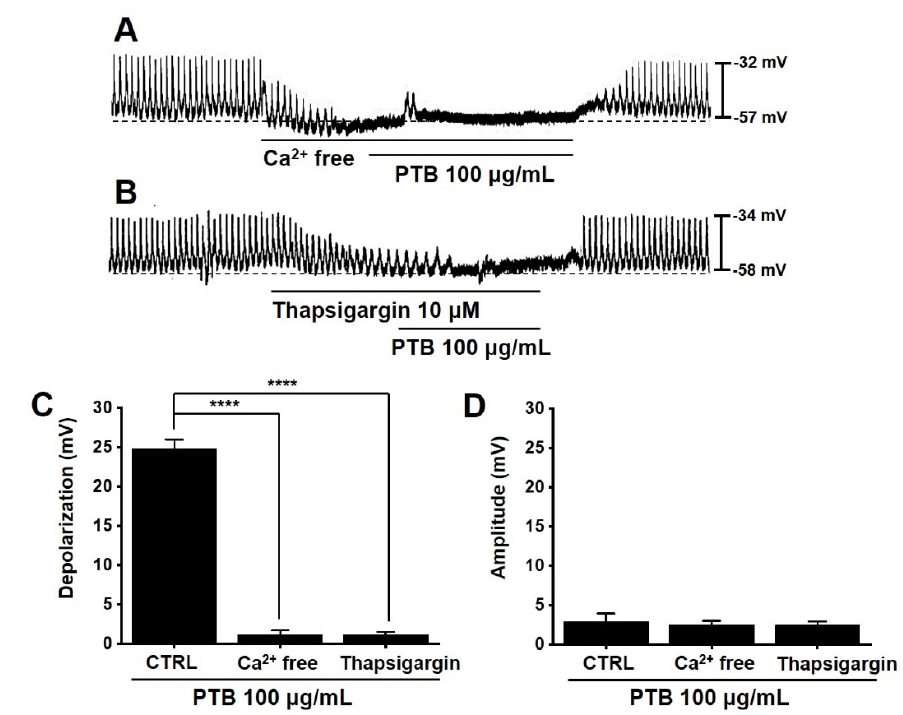
Figure 7. Effects of Ca 2+ on PTB extract-induced pacemaker potential depolarization. ( A ) For external Ca 2+ -free solution, PTB extract did not result in depolarization. ( B ) With thapsigargin, PTB extract also did not result in depolarization. ( C , D ) Depolarization and amplitude responses to PTB extract are summarized. Means ± SEs. **** p < 0.0001. PTB: Pinellia ternate Breitenbach. CTRL: control.